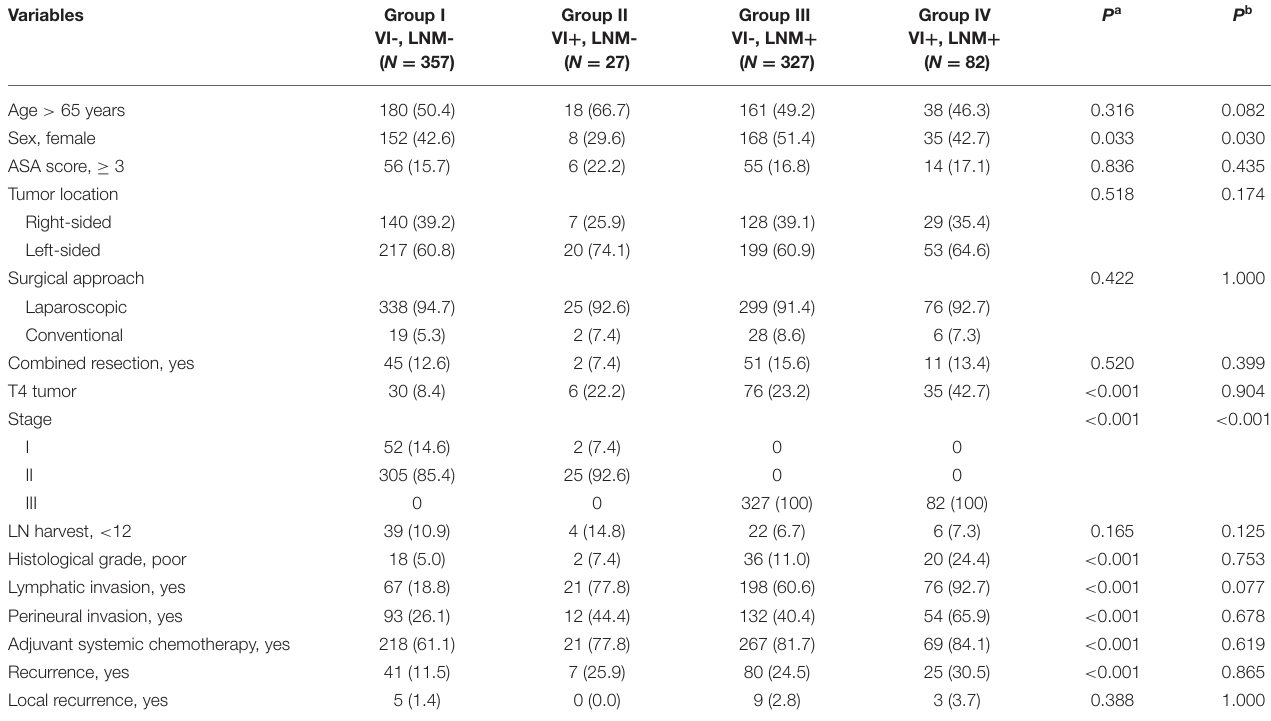
TABLE 2 | Patient’s clinico-pathological characteristics according to the groups.